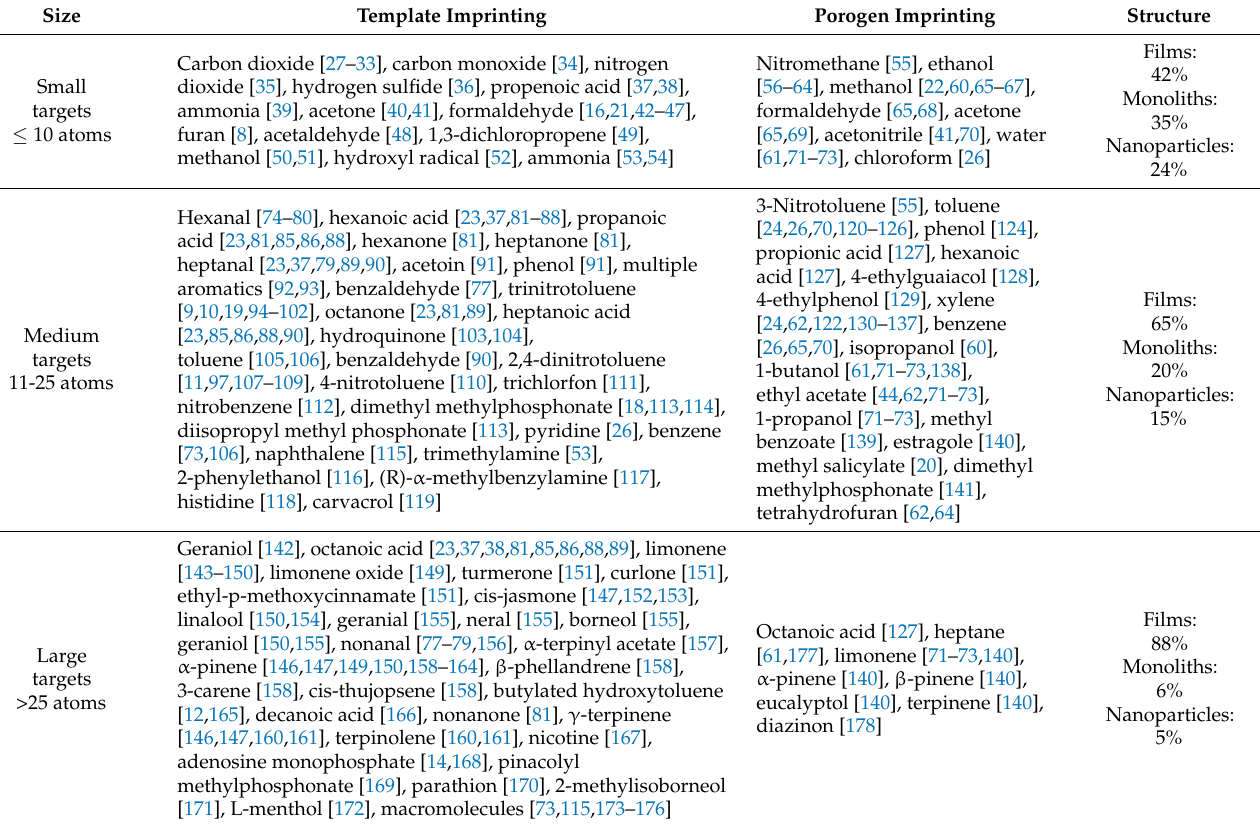
Table 1. Molecules targeted by gas phase molecular imprinting. Attempts were made to include a record of every example of gas phase applications of molecularly imprinted polymers in the literature. Targets are categorised by number of atoms and the imprinting technique used in the MIP